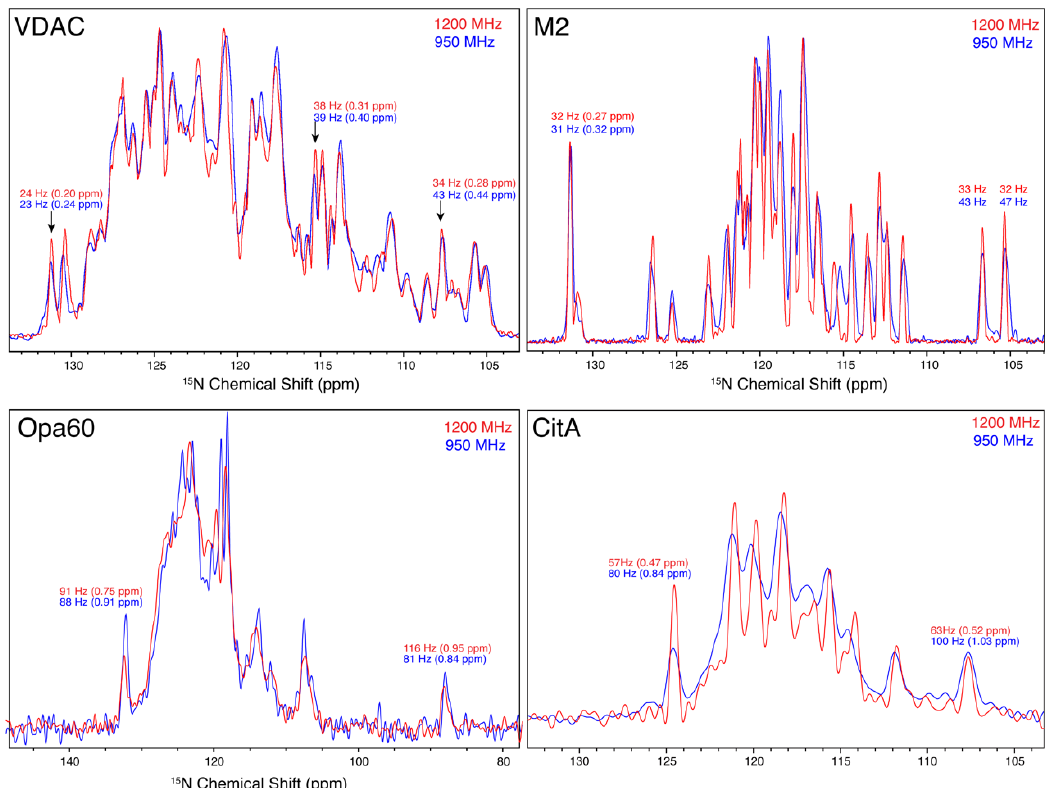
Figure 6. Nitrogen linewidths of the four proteins. Red spectra are from the 1200 MHz instrument, while blue spectra were recorded at 950 MHz. The proteins are indicated in the top left of each panel, VDAC, M2, Opa60, and CitA.